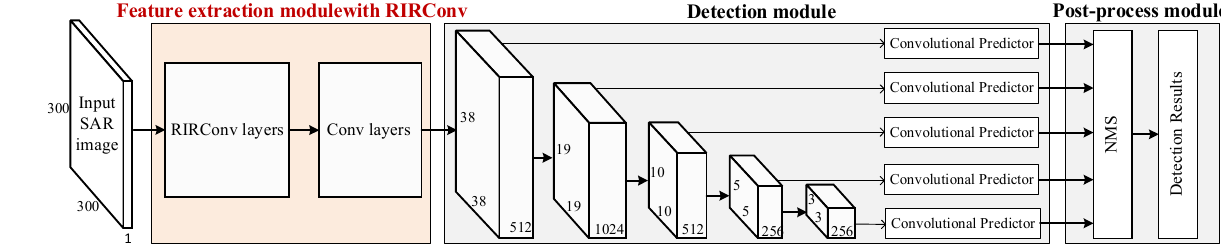
Figure 1. The architecture of the proposed vehicle target detection network for SAR